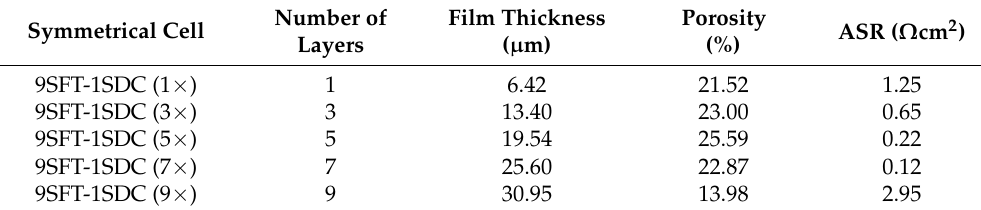
Number of Film Thickness Layers ( µ m)